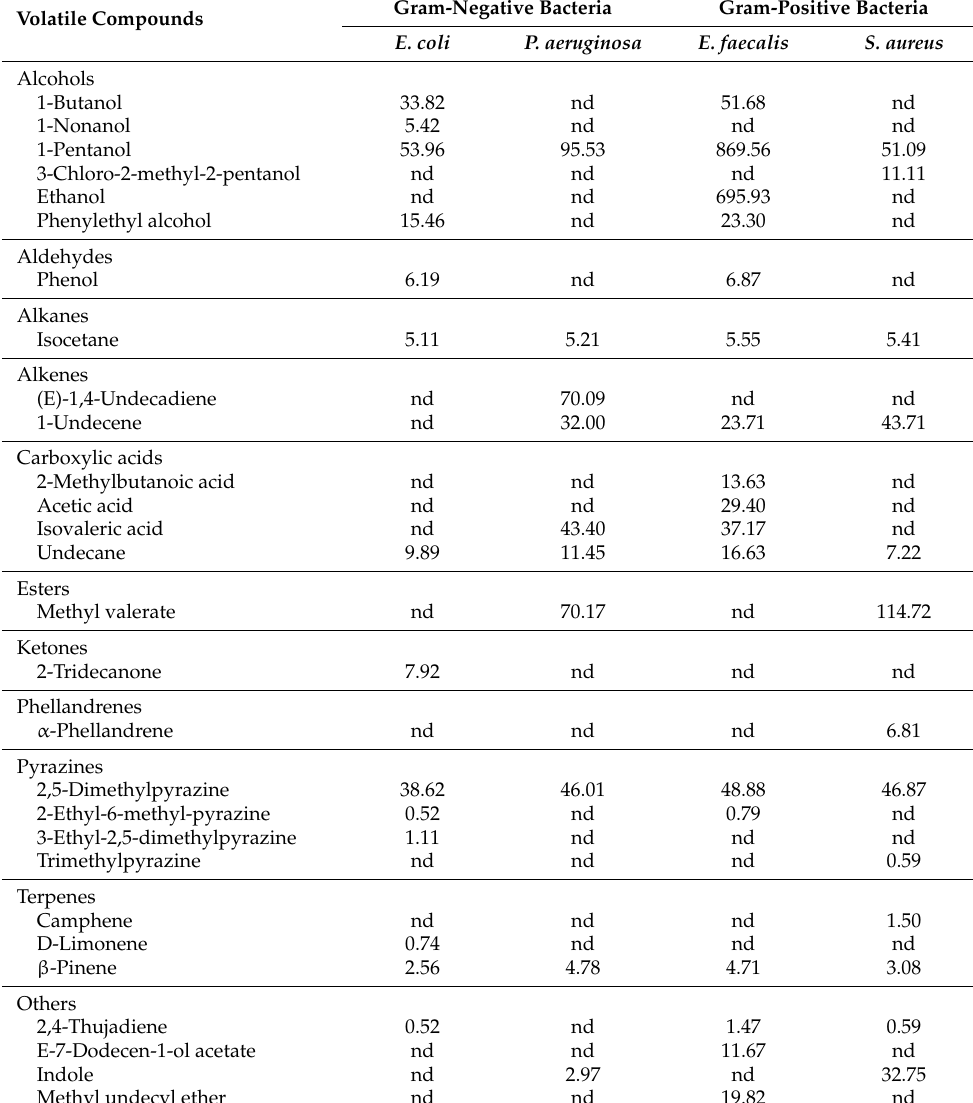
Table 1. Identified volatile compounds and respective average amounts (ng of compound as internal standard equivalents), for the E. coli , P. aeruginosa , E. faecalis , or S. aureus , grown overnight in BHI solid medium after incubation with a 10 − 4 dilution for E. faecalis and 10 − 5 dilution for the other bacterial strains. Volatile